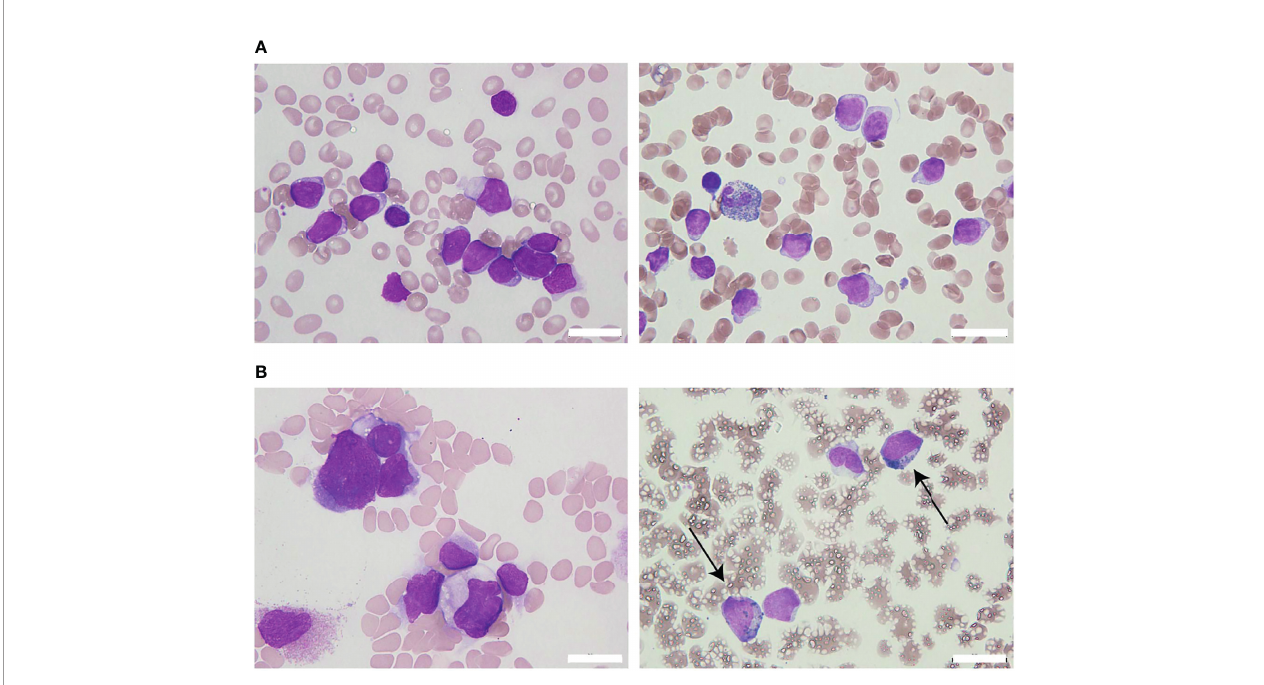
FIGURE 1 | The appearance of leukemia cells in the present case. (A) At initial diagnosis, the bone marrow (BM) was fi lled with morphologically monotonous myeloperoxidase (MPO)-negative leukemic blast cells (May – Giemsa stain [left]; MPO stain [right]; original magni fi cation, 1,000×). (B) After the fourth regimen of chemotherapy, the BM presented with an increased number of MPO-positive leukemia blasts (arrows; May – Giemsa stain [left]; MPO stain [right]; original magni fi cation, 1,000×). White bars in the right bottom portion of the fi gure represent 20 µm